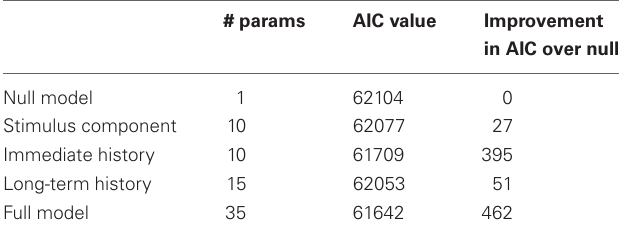
Table 2 | Computation of AIC values for component and full models. # params AIC value Improvement in AIC over